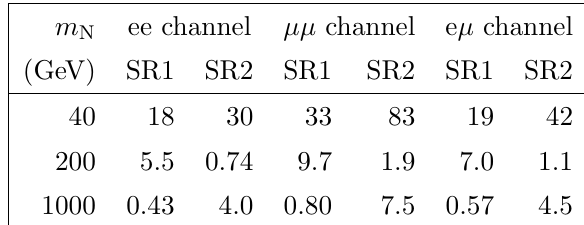
Table 5 . Observed event yields and estimated background for the signal region selections. The background predictions from prompt SS leptons, misidenti(cid:12)ed leptons, leptons with mismeasured sign, and the total background are shown together with the number of events observed in data. The uncertainties shown are the statistical and systematic components, respectively. A dash indicates that the background is considered negligible.